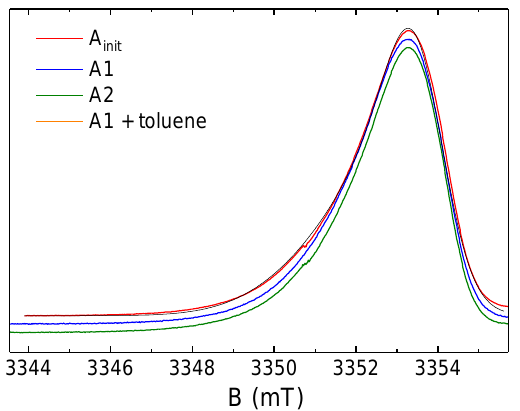
Figure 5. Comparison of the normalized ESE detected W-band EPR (Ainit, A1, A2) registered at T = 300 K and their corresponding fitting as the paramagnetic center of axial symmetry, with g ‖ ≈ 2.0045 and g ⊥ ≈ 2.0029. A1 in deuterated toluene (v:v = 1:20) was registered at T= 200 K. The decay of the transverse magnetization (ESE decay, T 2 -curve) in the X-band con- tains modulations (ESEEM, [54]) were caused by anisotropic electron–nuclear